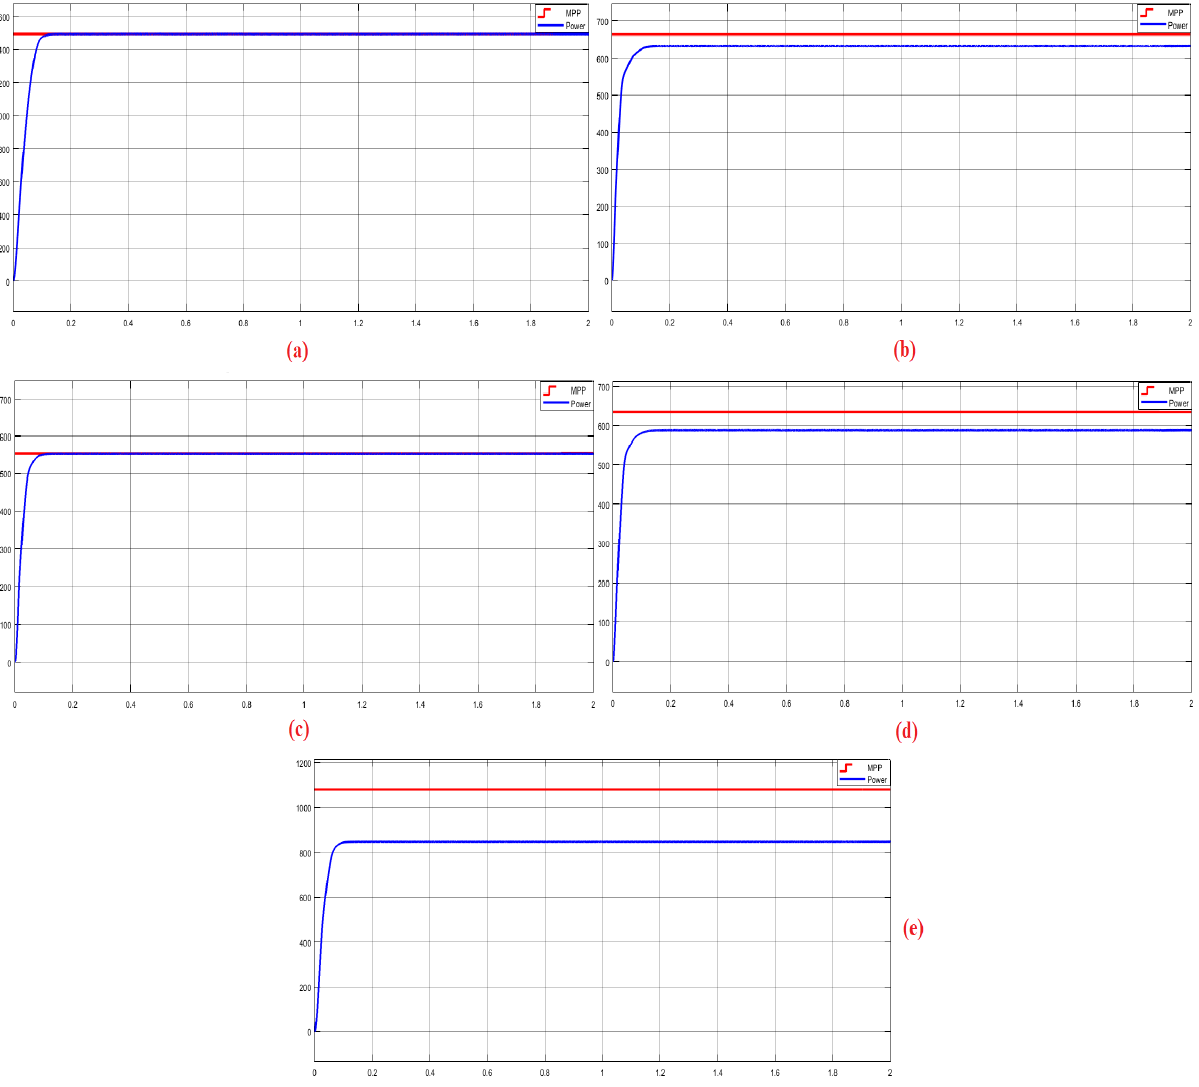
Figure 15. The power–time graph of MIC under different shading conditions. ( a ) For the UIC graph; ( b ) For the second CPSC graph; ( c ) For the third CPSC graph; ( d ) For the fourth CPSC graph; ( e ) For the fifth CPSC graph.